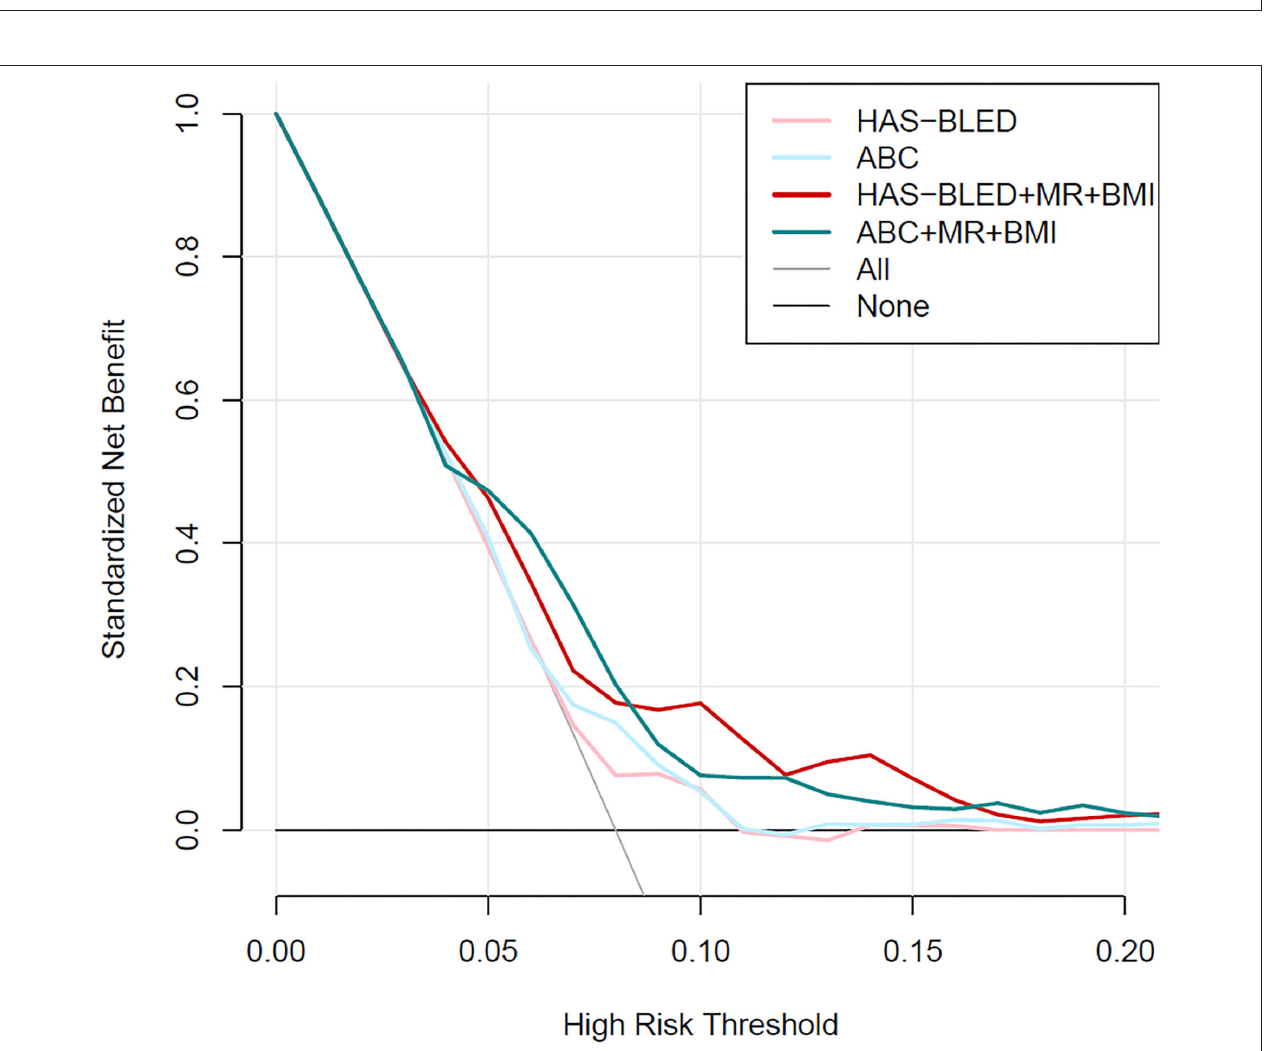
FIGURE 3 | Decision curve analysis for the HAS-BLED and ABC-bleeding risk prediction models combined with mitral regurgitation and body mass index or not.